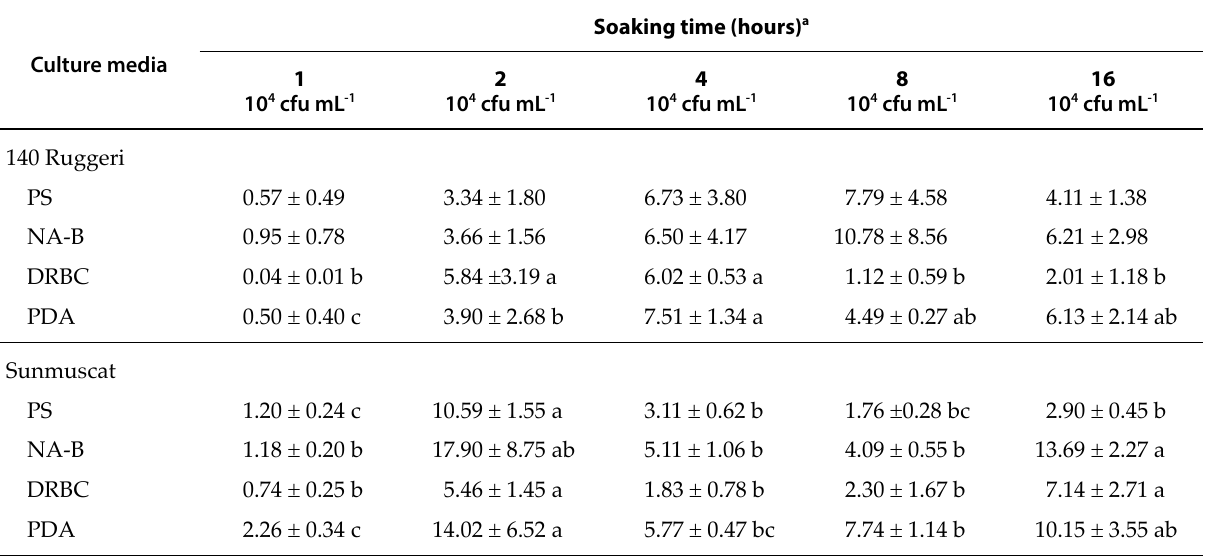
Table 1. Colony forming units (cfu) of bacteria and fungi isolated from soaking water of 140 Ruggeri and Sunmuscat cut -